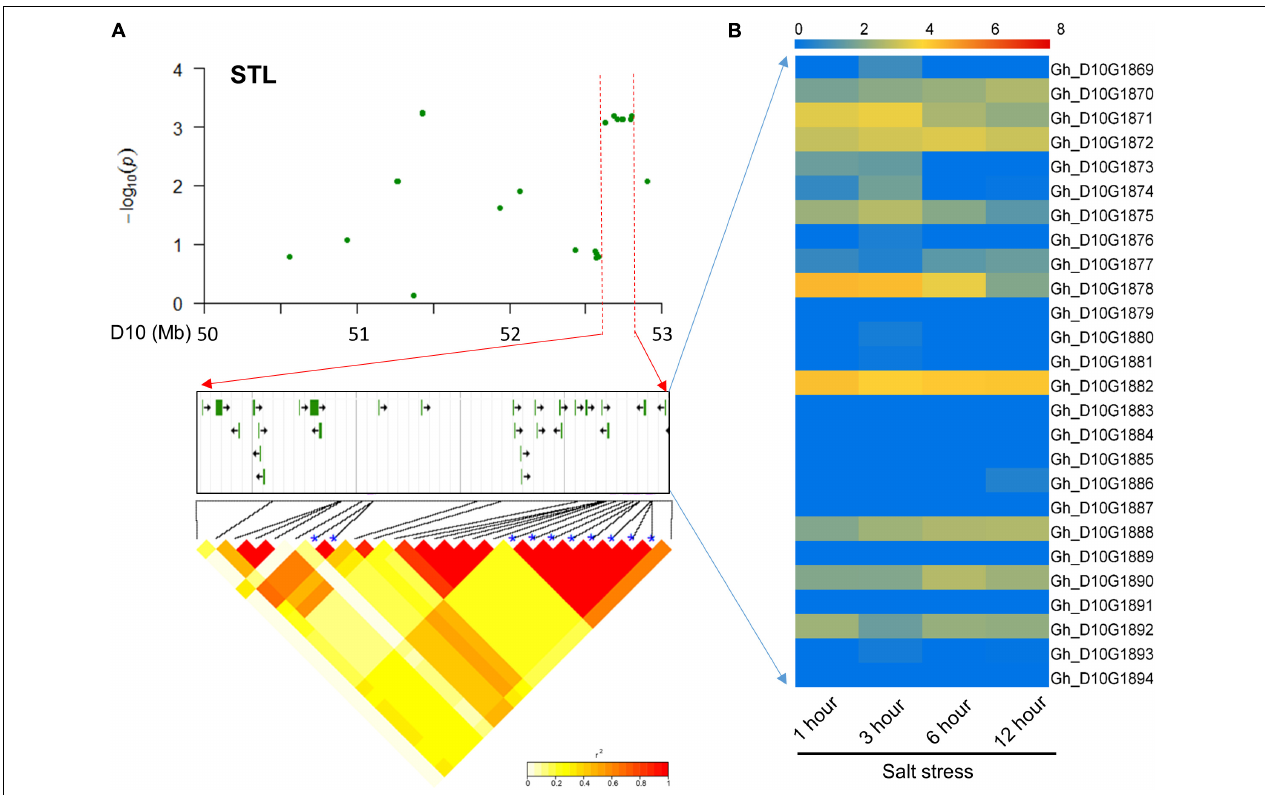
FIGURE 4 | Identification of the candidate genes for STL on the peak of chromosome D10. (A) Local Manhattan plot (top) and LD heatmap (bottom) surrounding the peak. The 26 candidate genes were presented in the middle. (B) Heat map of the expression of the 26 candidate genes at four time points. The samples were collected at 1, 3, 6, and 12 h under salt